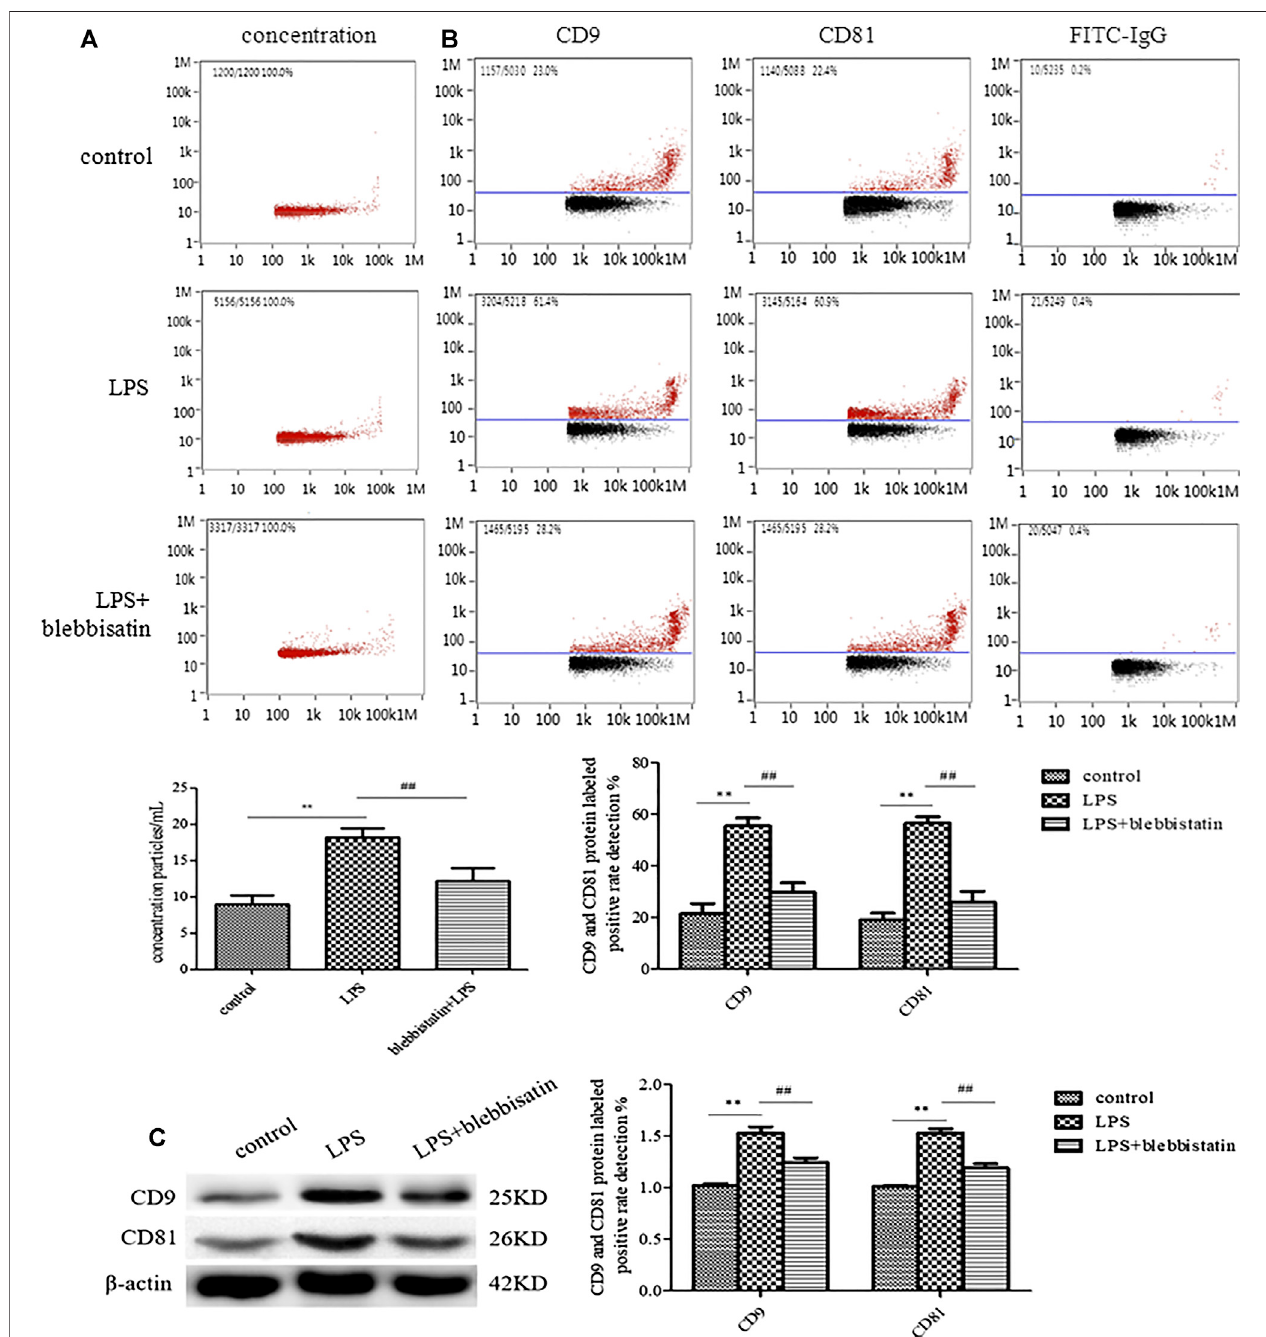
FIGURE 2 | The myosin inhibitor, blebbistatin, inhibited exosome release from microglial cells under the stimulation of LPS. The extracted exosomes were divided into those extracted from control microglial cells, microglial cells incubated with 1 mg/ml LPS for 24 h, and microglial cells added with 1 μ M blebbistatin 0.5 h before the 24 h stimulation of LPS. (A) Nanoparticle tracking analysis for the concentration of exosomes. (B) Flow cytometry analysis for CD9-labeled positive rate, CD81-labeled positive rate, or control FITC-IgG-labeled positive rate. (C) The protein expression levels of CD9 and CD81 exosome marker proteins were examined by western blot. Western blots were quanti fi ed. Nine independent experiments were analyzed. A histogram depicts the quantitative representation of CD9 and CD81 protein expression for each group. The data were averages ± SD, n (cid:2) 9. ** p < 0.01 vs. control microglial cells; ## p < 0.01 vs. microglial cells stimulated with LPS.